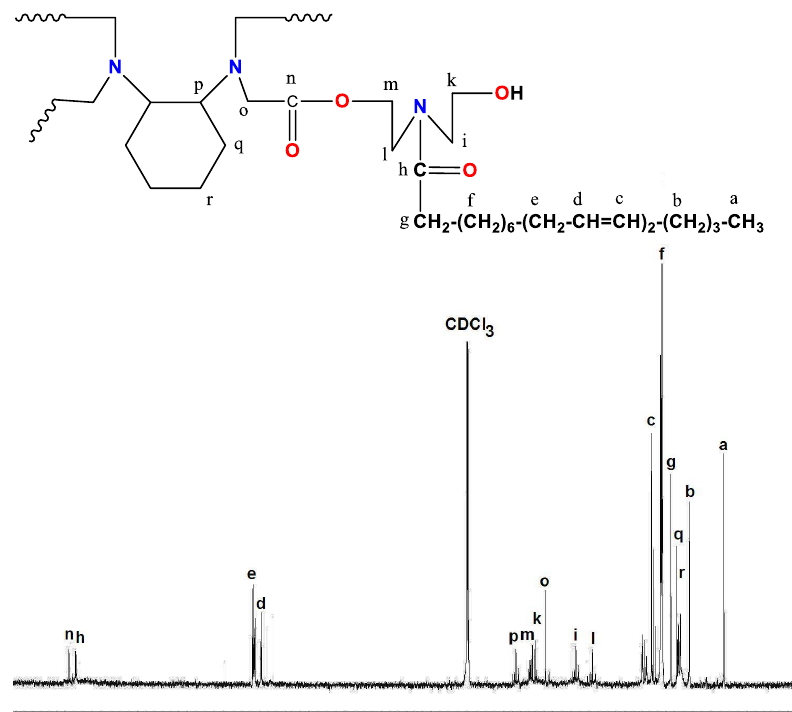
Figure 4. 1 H NMR spectra of PUDCEA Figure 4: 1 H NMR spectra of PUDCEA.